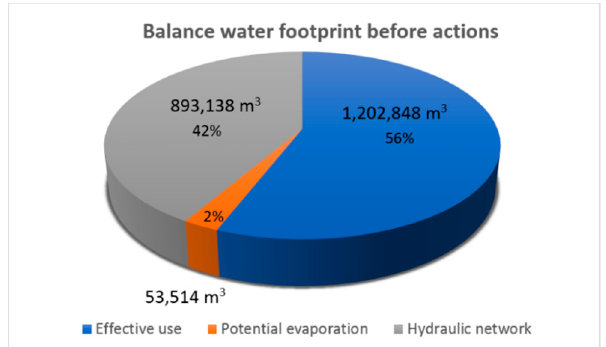
Figure 7. Balance water footprint before actions. Source: Own elaboration.